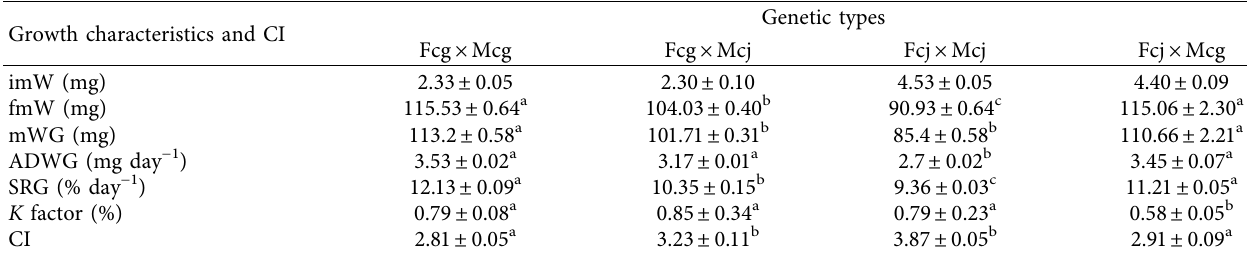
Table 1: Characteristics of weight growth and food consumption index of fry according to genetic type in reciprocal hybridizations of C.gariepinus × C. jaensis at 32 days of age in happas. Growth characteristics and